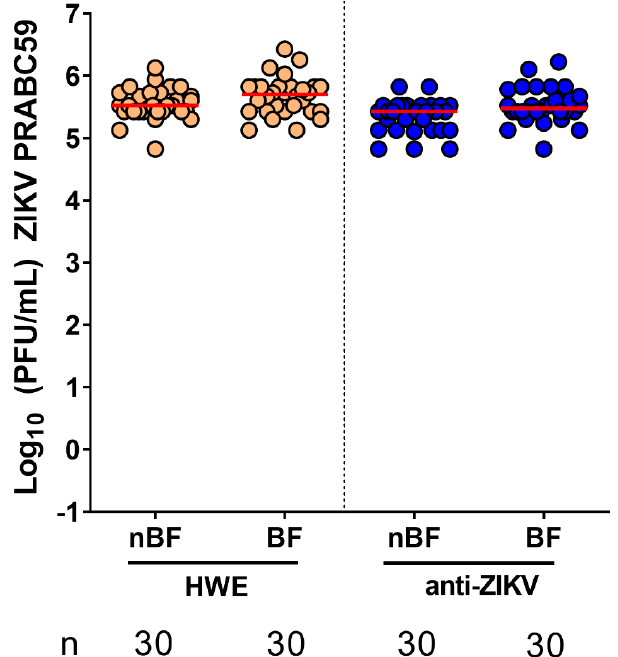
Figure 6. Anti-ZIKV-NS3 / 4A transgenics lose virus resistance when their midgut infection barrier is bypassed. After intrathoracic virus injection, both HWE mosquitoes ( left ) and anti-ZIKV-NS3 / 4A (“anti-ZIKV”) transgenic mosquitoes ( right ) either received a non-infectious bloodmeal (to induce expression of the transgene) or a sugarmeal. Red bars indicate medians. nBF = non-bloodfed (sugarmeal), BF = bloodfed, n = number of mosquitoes tested.